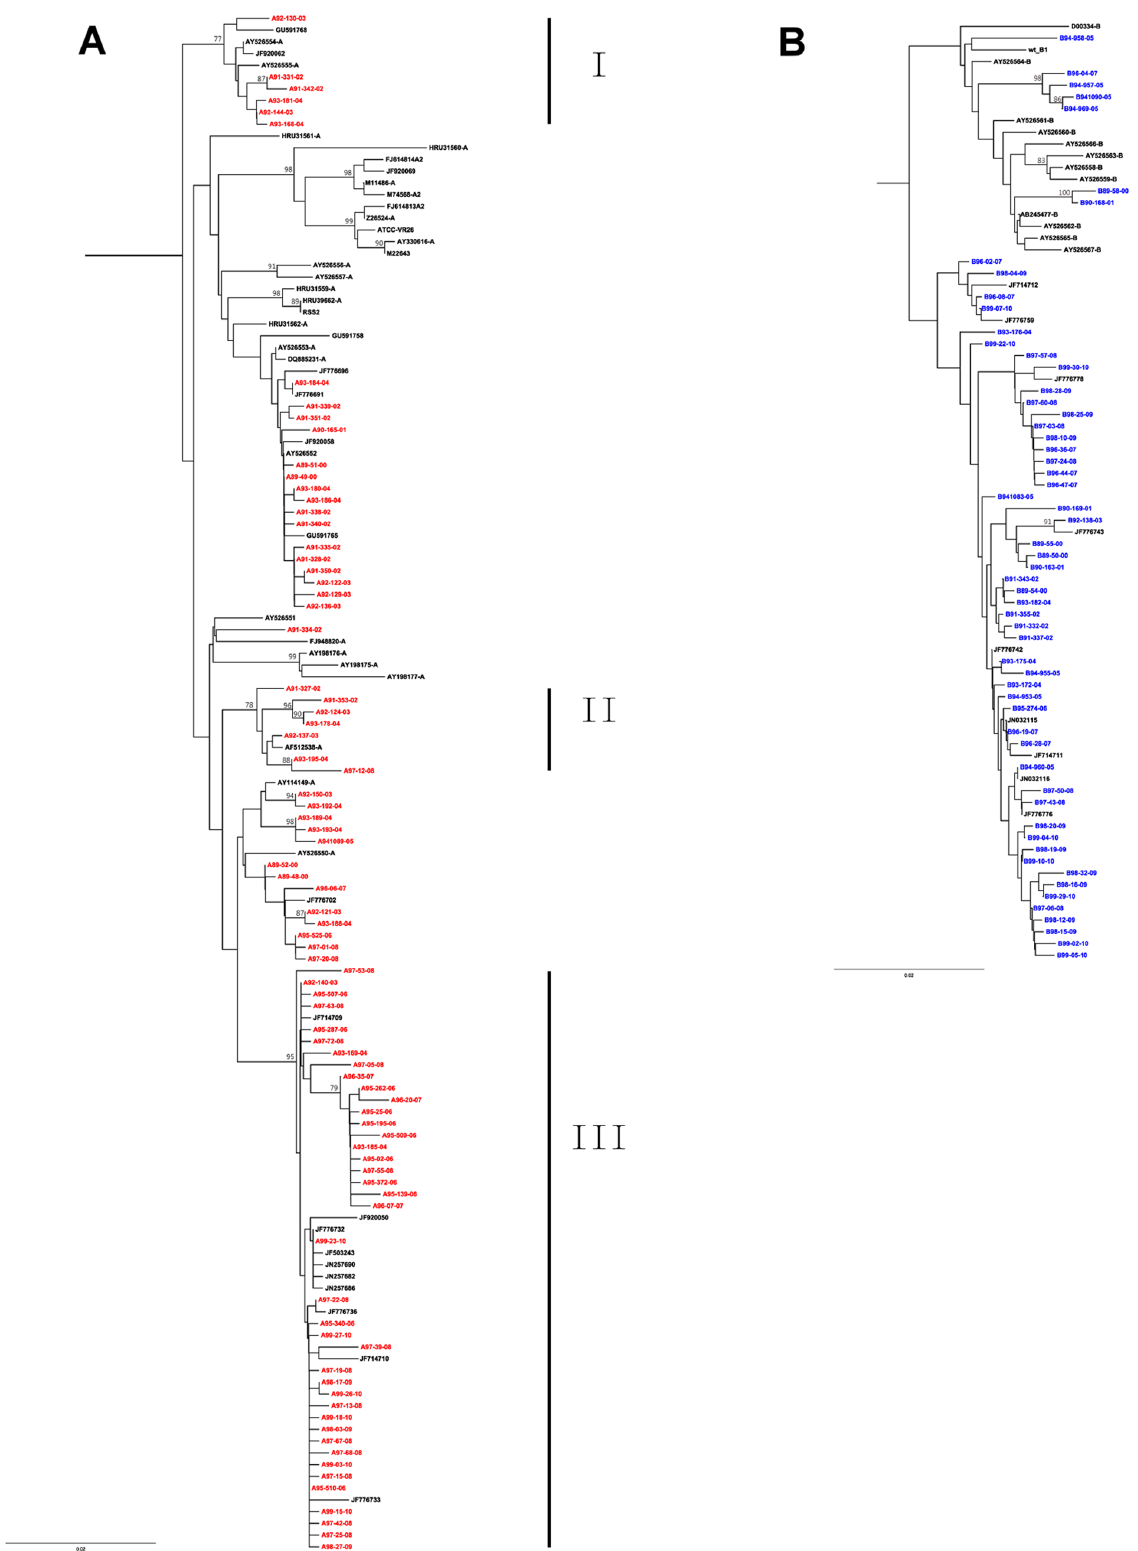
Figure 2. Phylogenetic analysis of the RSV partial F gene (nt 110–869). The tree topology was constructed using the neighbor-joining method. Only bootstrap values greater than 75% (1,000 bootstrap replicates) are shown. Panels A and B show details for RSV-A and RSV-B. Red and blue texts indicate the Taiwanese RSV-A and RSV-B strains, respectively. The scale bar represents the evolutionary distance.